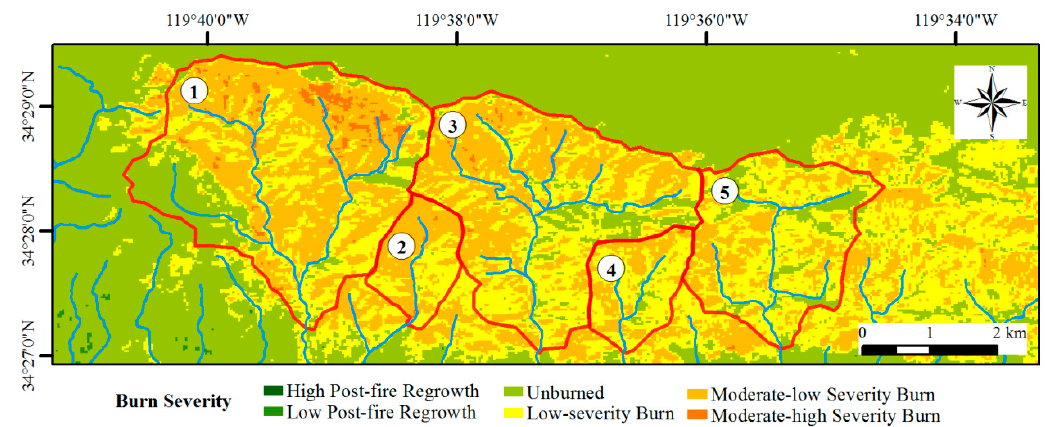
Figure 6. Burn severity around Montecito.